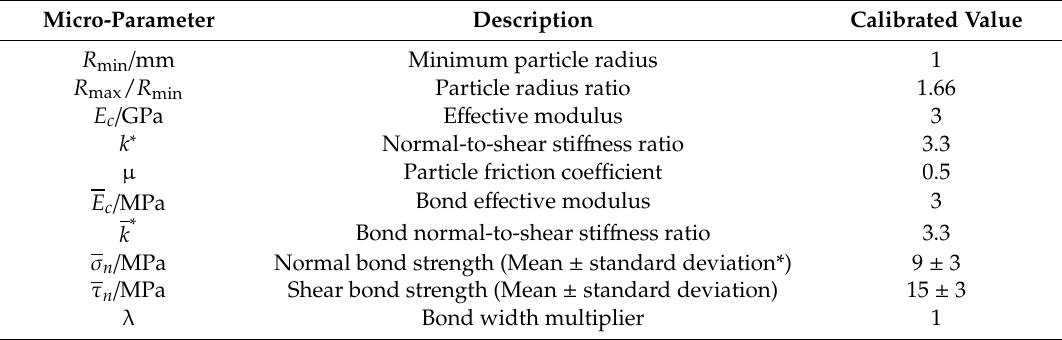
Table 2. Calibrated micro-parameters of the PFC3D